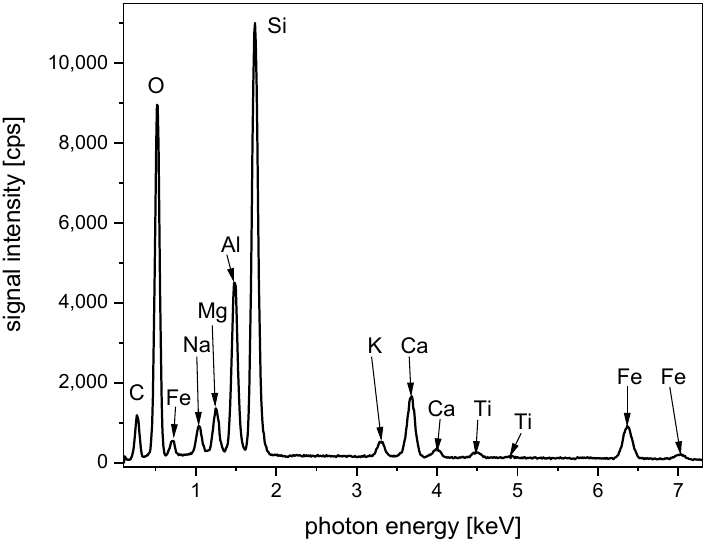
Figure 30. EDS spectrum taken from basalt fibers. The determined surface composition is in at-%: carbon 37.5; oxygen 36.9; silicon 13.3; aluminum 5.1; calcium 2.1; iron 1.6; magnesium 1.5; sodium 1.4; potassium 0.5; titanium 0.2.